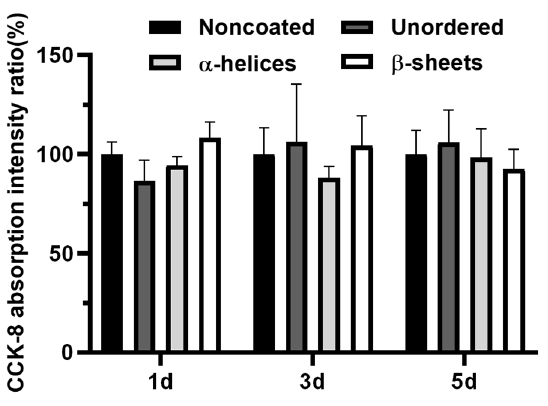
Figure 6. Cell proliferation of RAW 264.7 cells assessed by CCK-8 cell viability assay. No statistical difference was found among the tested groups ( p -value < 0.05). N = 4 for each group at each time point.